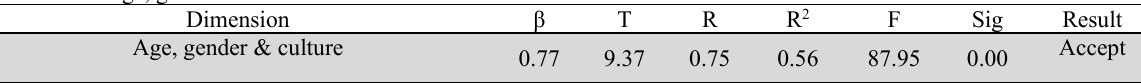
Results of test age, gender & culture in brand selection